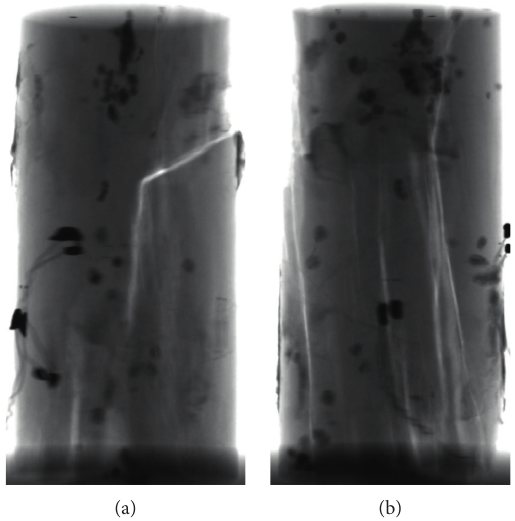
Figure 14: CT scanning pictures of failure coal sample: (a) left view, (b) rear view, (c) right view, and (d) final damage specimen.